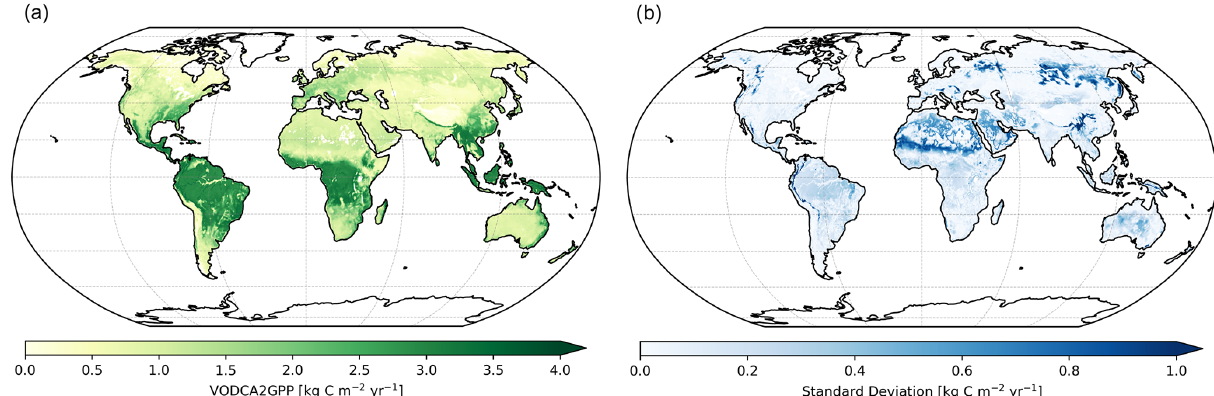
Figure 2. (a) Mean annual GPP as derived from VODCA2GPP for the period 1988–2019. (b) Standard deviation of mean annual GPP (1988–2019) as obtained by the uncertainty analysis based on site-level cross-validation.